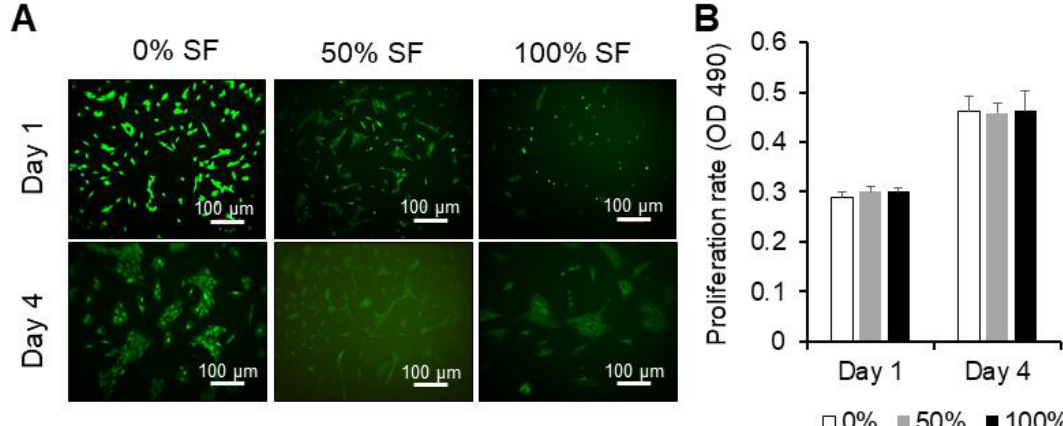
Figure 3. Proliferation rate and calcein staining for viability of BMMSCs co-cultured with allogeneic synovial fluid. ( A ) Representative BMMSCs after exposure to different concentrations of allogeneic synovial fluid at days 1 and 4. MSCs were loaded with calcein AM (stains live cells green) and propidium iodide (stains dead cells red). ( B ) Proliferation was evaluated by MTS assay; the absorbance was measured at 490 nm. Quantitative data are expressed as mean ± SD ( n = 3) and were analyzed using one-way ANOVA, with Tukey’s comparison test as a posttest. p < 0.05 was considered statistically significant. One representative experiment is presented from three different experiments using cells from different donors ( n = 3), each performed in triplicate. Scale bars = 100 µm.